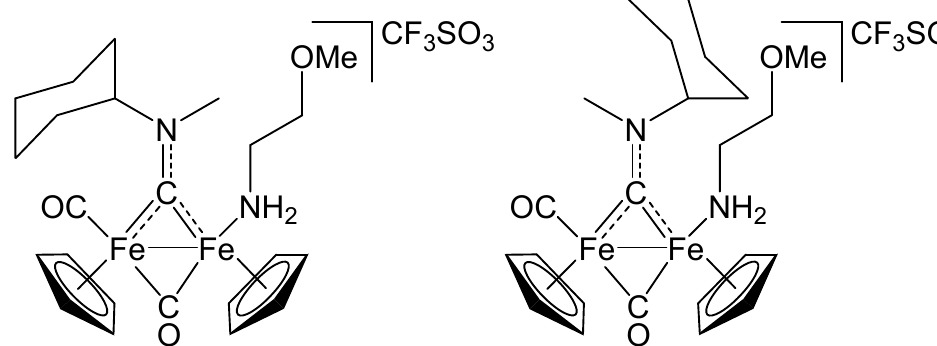
Figure 3. Structure of 2c ( left : α isomer; right : β isomer).